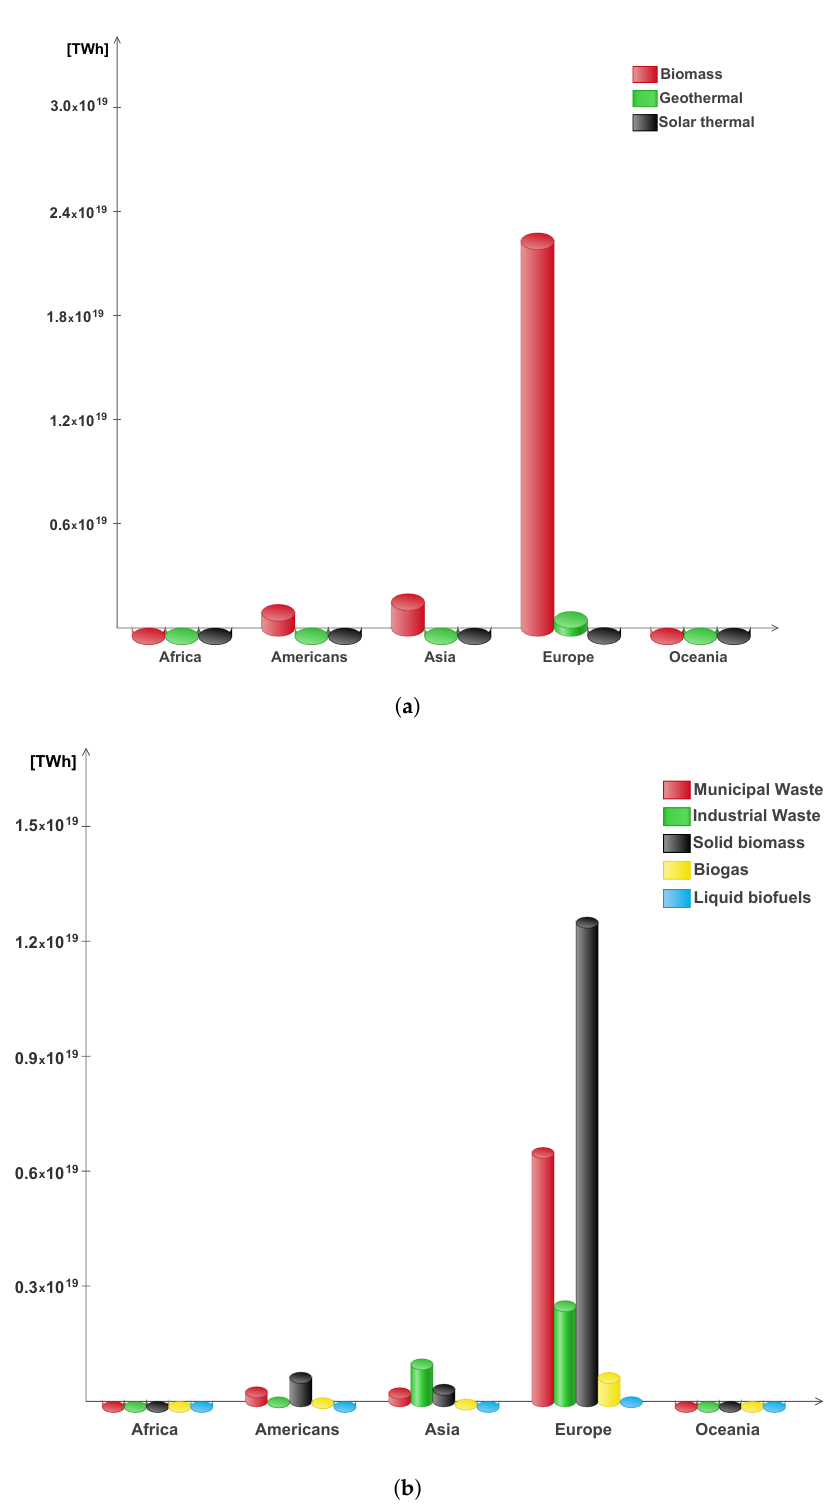
Figure 4. Regional distribution of the heat production from ( a ) Renewables and ( b ) Biomass in 2015. Data from: Reference